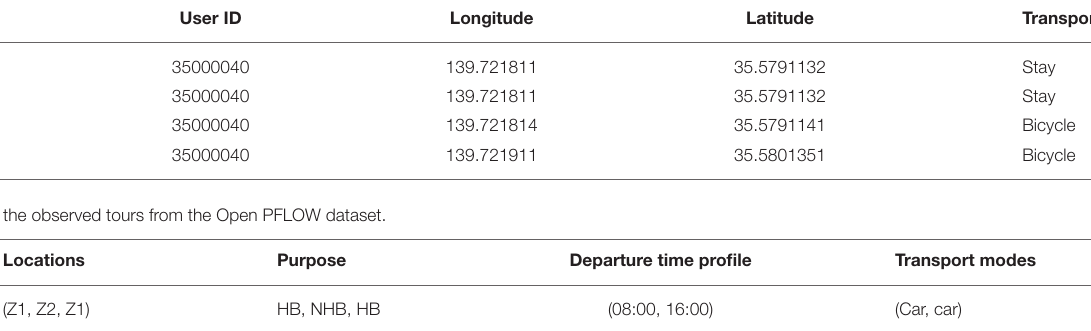
TABLE 1 | Extract from the Open PFLOW dataset.